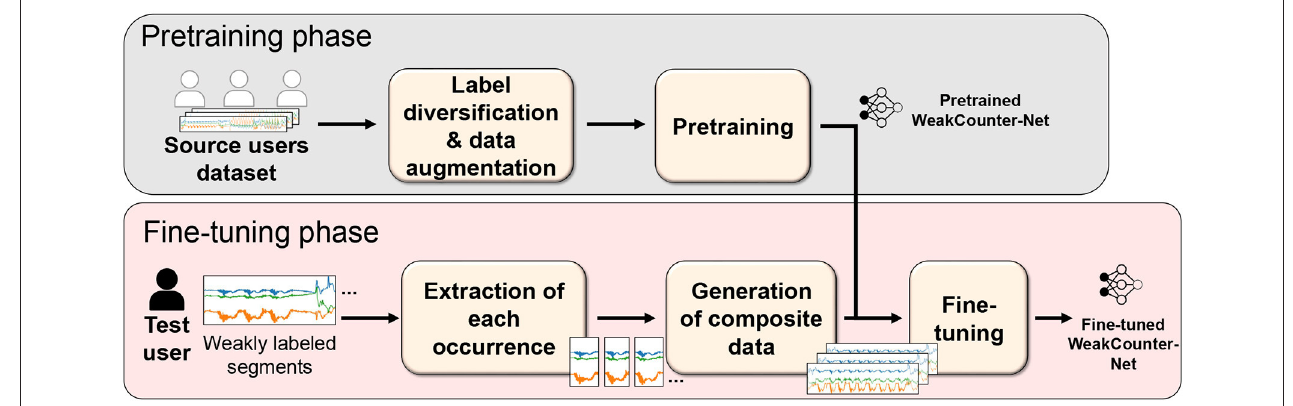
FIGURE 3 | Overview of few-shot weakly supervised repetition counting